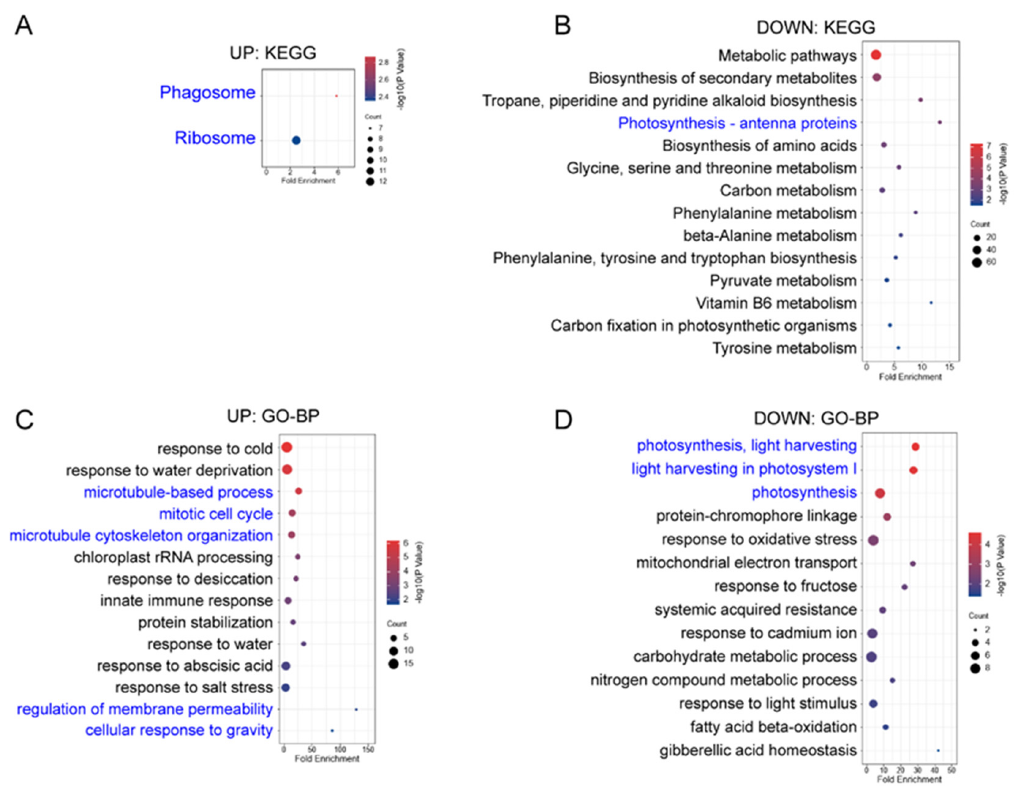
Figure A2. KEGG and GO enrichment analysis of the second repetition of differentially expressed proteins (DEPs-Rep2, ICFI ≥ 1.5) in “ upl5-1 vs. Col-0” group. ( A , B ) KEGG enrichment analysis of up-regulated DEPs-Rep2 ( A ) and down-regulated DEPs-Rep2 ( B ); ( C , D ) GO enrichment analysis- biological process of up-regulated DEPs-Rep2 ( C ) and down-regulated DEPs-Rep2 ( D ).